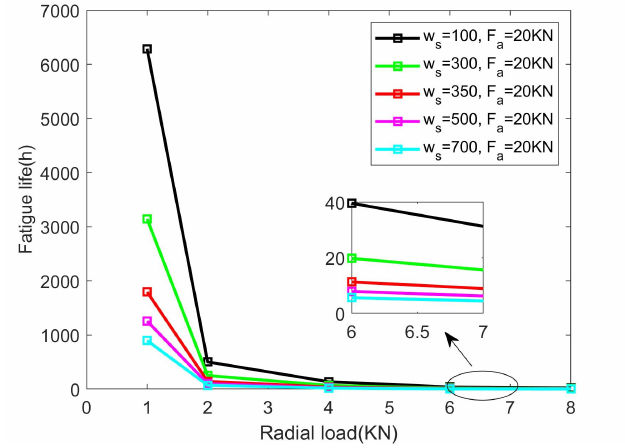
Figure 21. The fatigue life with different radial loads of case